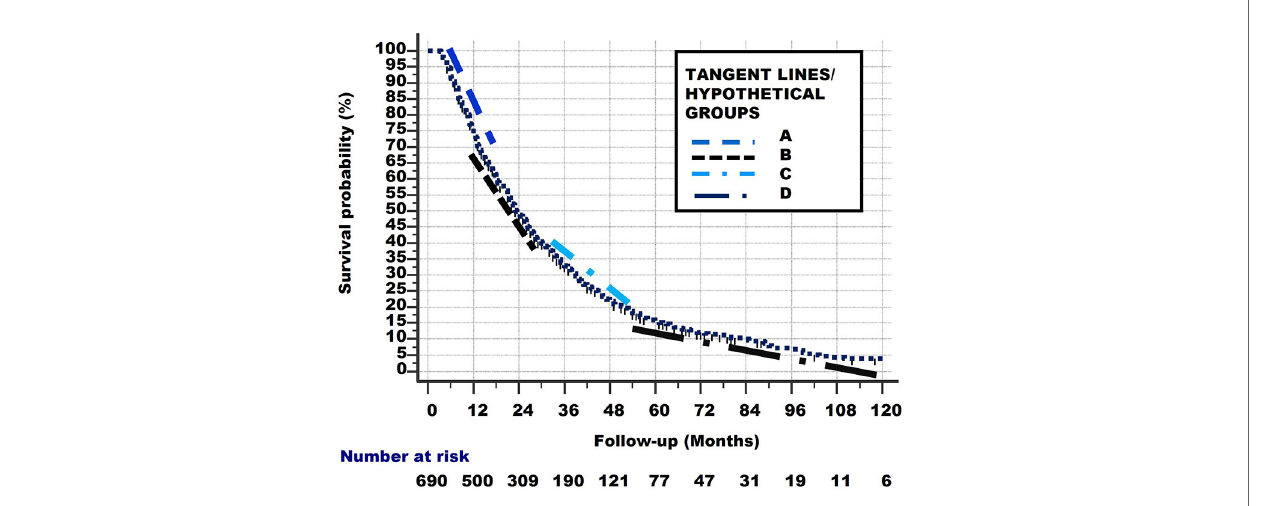
FIGURE 8 | Linear lines between points P – Q, Q – R, R – S, S – T. These lines are slightly shifted up and down, and to the left and right in the fi gure, to make them more